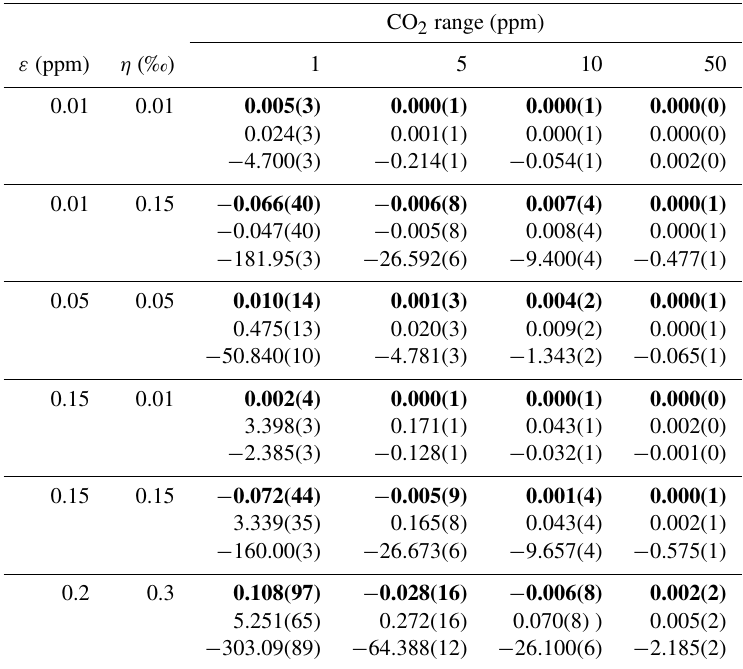
Table 1. Bias in retrieved isotopic source signatures from Keeling line fits for (cid:49)c ≤ 50ppm, expressed as differences from the true value of − 25, in units of ‰. Each cell contains, from top to bottom, the York (in bold), the OLS, and the GMR result. 1 σ uncertainties in the final digit(s) are given in parentheses, based on the standard deviation of the ensemble of 5000 fits. CO 2 range